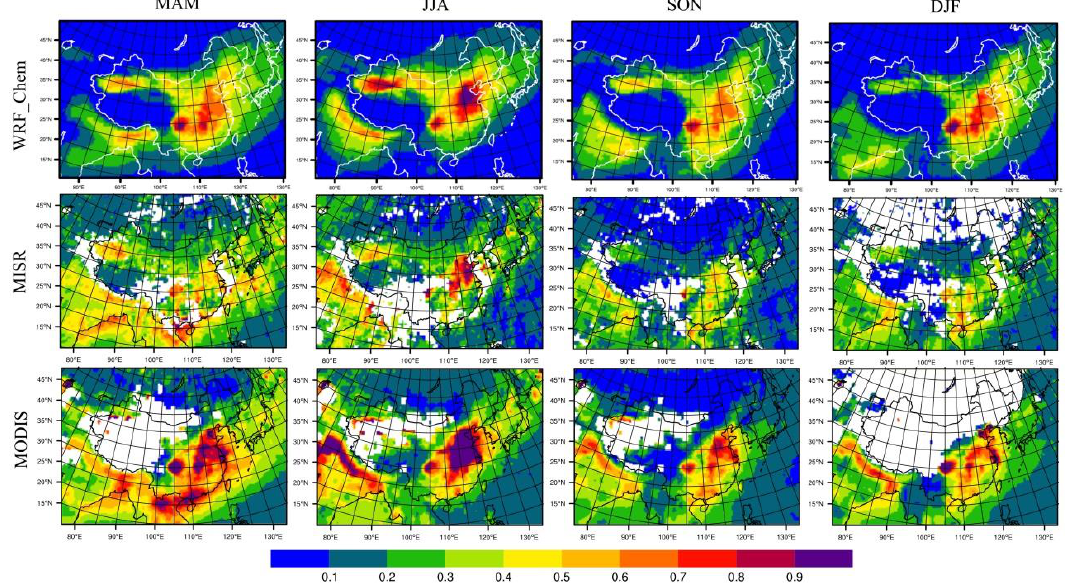
Figure 2. Seasonal average AOD at 550 nm over East Asia in 2010 from WRF-Chem simulations ( top ), and from Multi-angle Imaging SpectroRadiometer (MISR) ( middle ) and Moderate Resolution Imaging Spectroradiometer (MODIS) ( bottom ) retrievals.